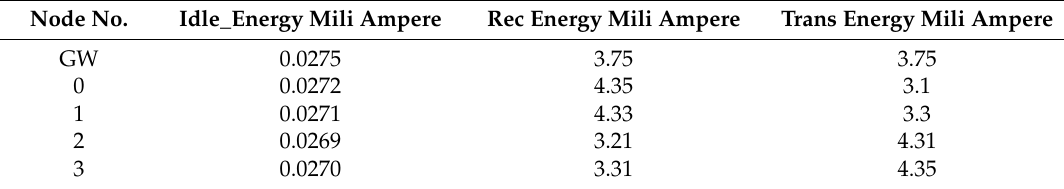
Table 6. Energy Measurements before node 0 affected by rain (Standard Ad hoc On-Demand Multipath Distance Vector (AOMDV)).